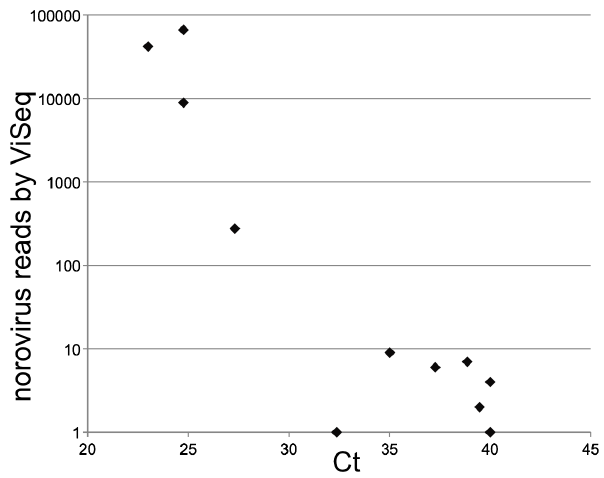
Figure 3. Detection of norovirus by real-time PCR vs the ViSeq process. Total ViSeq identified norovirus reads were compared to the Real time PCR determined norovirus viral loads. Pearson’s correlation coefficient for all samples ( 2 0.69), for all samples with Ct values below 35 (0.63) and for all samples with ViSeq reads above 10, ( 2 0.59), indicate a strong negative correlation between the two methods of